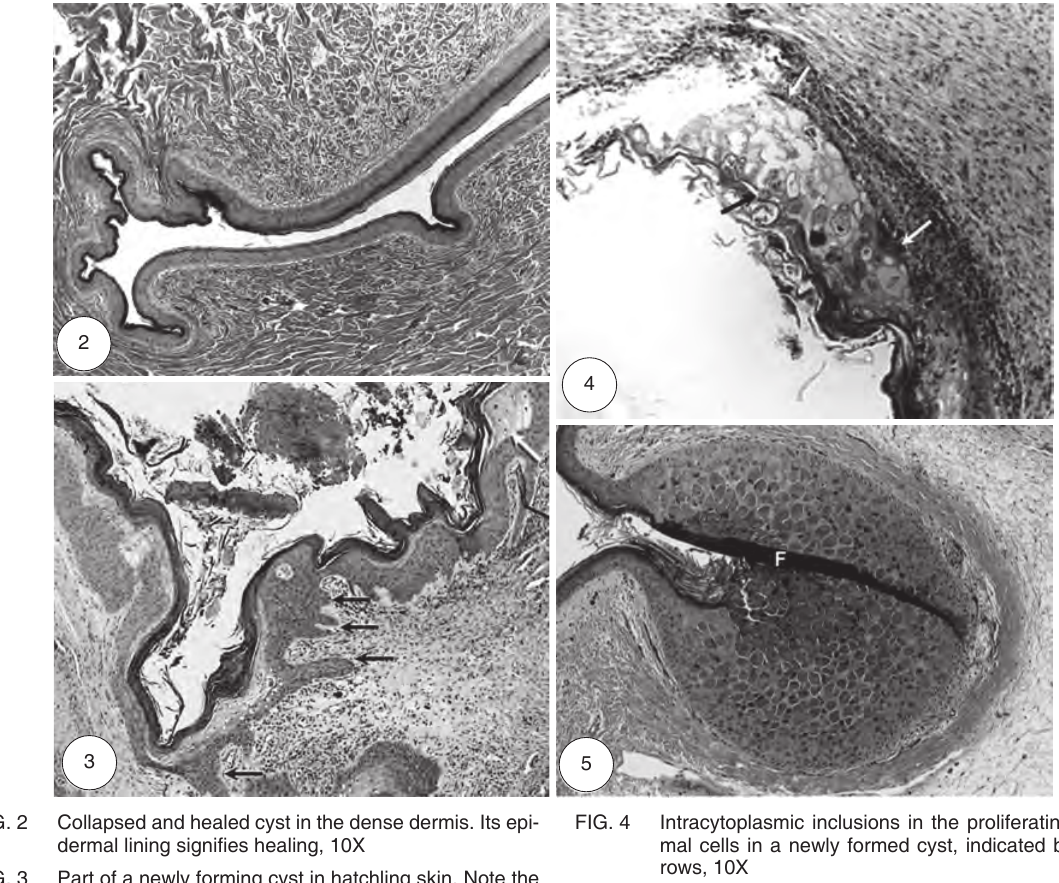
FIG. 2 Collapsed and healed cyst in the dense dermis. Its epi- dermal lining signifies healing, 10X FIG. 3 Part of a newly forming cyst in hatchling skin. Note the finger-like epidermal projections (columns) penetrating further into the dermis (black arrows). Several inclusion bodies are indicated by the white arrows, 5X